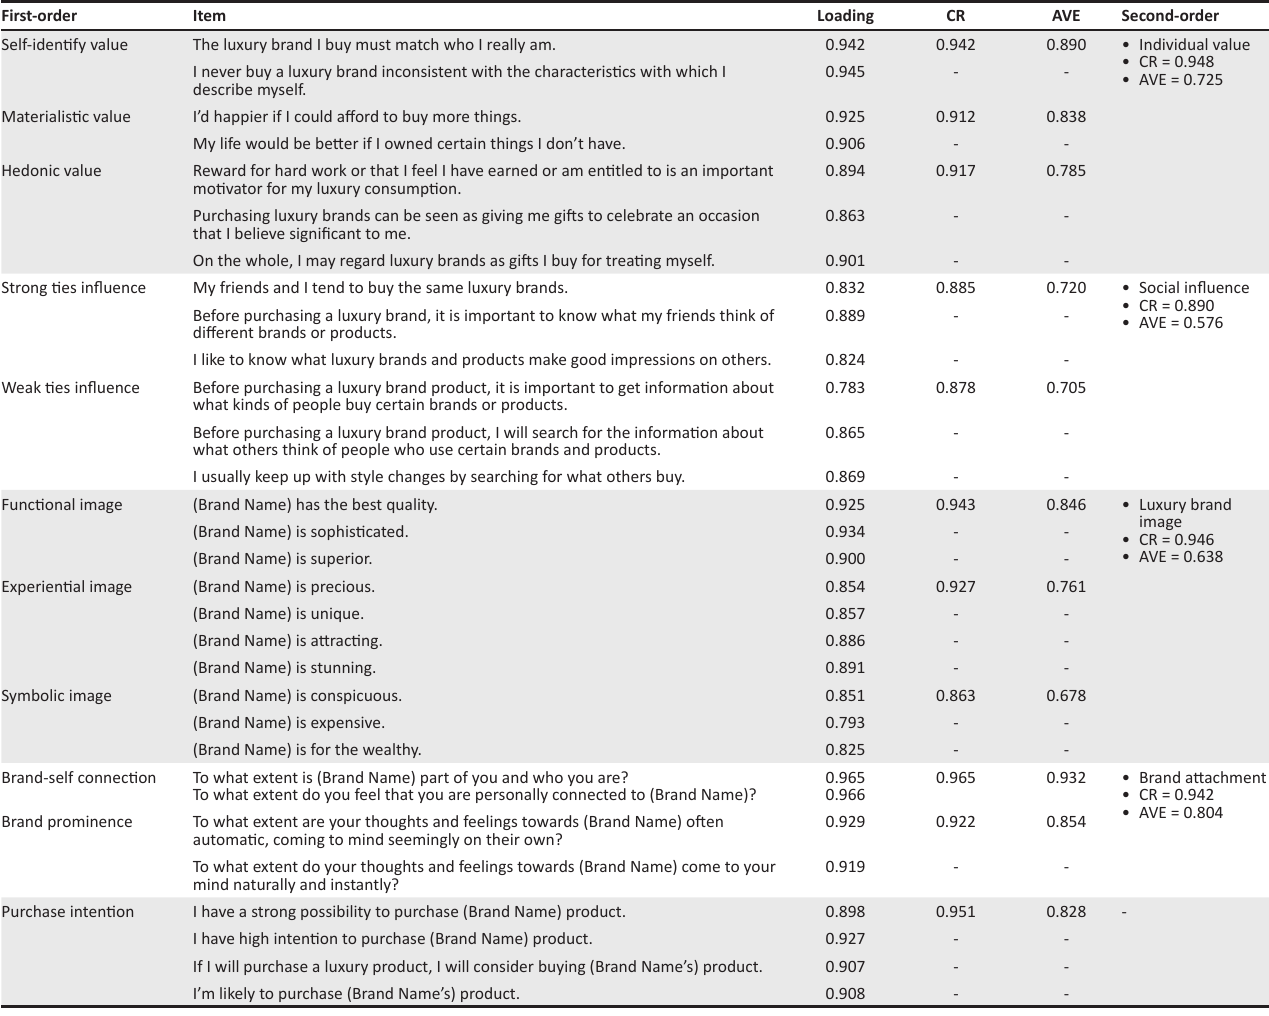
TABLE 2: Confirmatory factor analysis results of the measurement